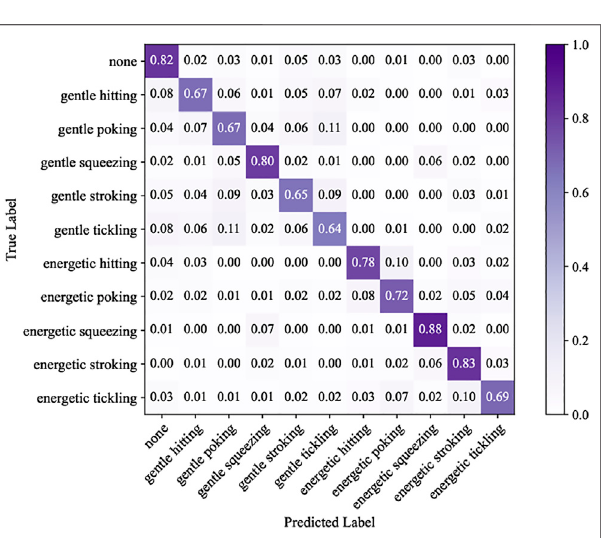
FIGURE 5 | Normalized confusion matrices showing the classi fi cation results for both force intensity and gesture together.